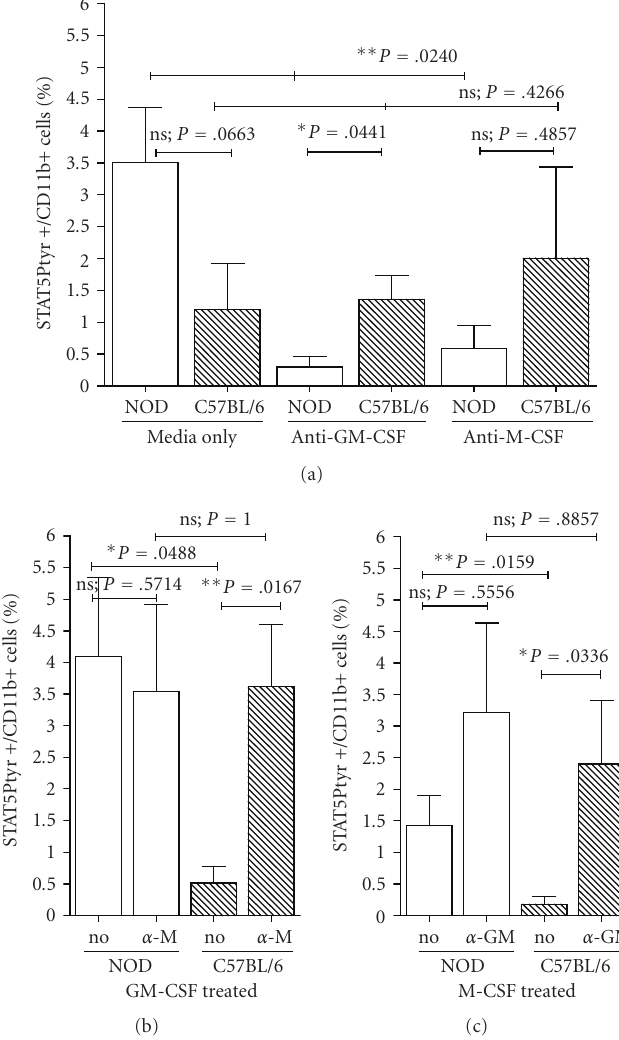
Figure 1: Flow cytometric analysis of STAT5 phosphorylation in in vitro myeloid di ff erentiation. (a) Bone marrow cultures (1 million cells/mL) from NOD and C57BL/6 control mice were di ff erentiated in culture with either, (b) 1000U/mL GM-CSF plus 2 μ g/mL anti-M-CSF blocking antibodies α -M), or (c) with 500U/mL M-CSF with 2 μ g/mL anti-GM-CSF blocking antibodies α -GM), for 48 hours at 3 ◦ C/5CO 2 . Cultures treated with medium only (“media only” in (a), “0” in (b) and (c)) or with medium supplemented only with antibodies to block M- CSF or GM-CSF (ANTI-M-CSF, ANTI-GM-CSF, respectively, in (a)) were run in parallel with the cytokine-stimulated cultures. In addition, separate aliquots of bone marrow cells were cultured in M-CSF or GM-CSF alone without blocking antibodies (“no” in (b) and (c)). At 48 hours, cells were stained with anti-STAT5Ptyr-FITC and anti-CD11b-PE antibodies for analysis by intracellular immune-histochemical flow cytometry. Strain and treatment regiments for each pair of cultures are listed on the X -axis. The percentage of STAT5Ptyr+ in CD11b+ cells is given on the Y -axis. Graphs are representative of 3–9 separate runs of each treatment. The p -values indicated were derived from Mann- Whitney U test, Student’s t- test, or one-way ANOVA analyses, as appropriate, for the sample group comparisons indicated by